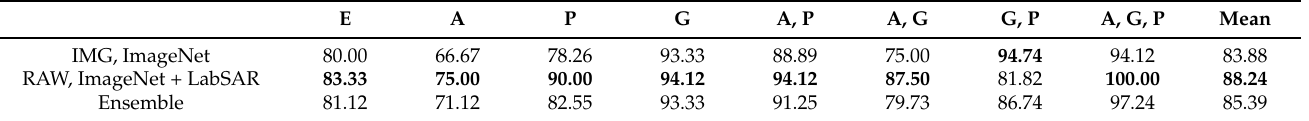
Table 7. Per-class F1 scores and the macro F1 score of the two best models and their ensemble on the test set. Classes: E—Empty, A—Aluminium, P—Plastic, and